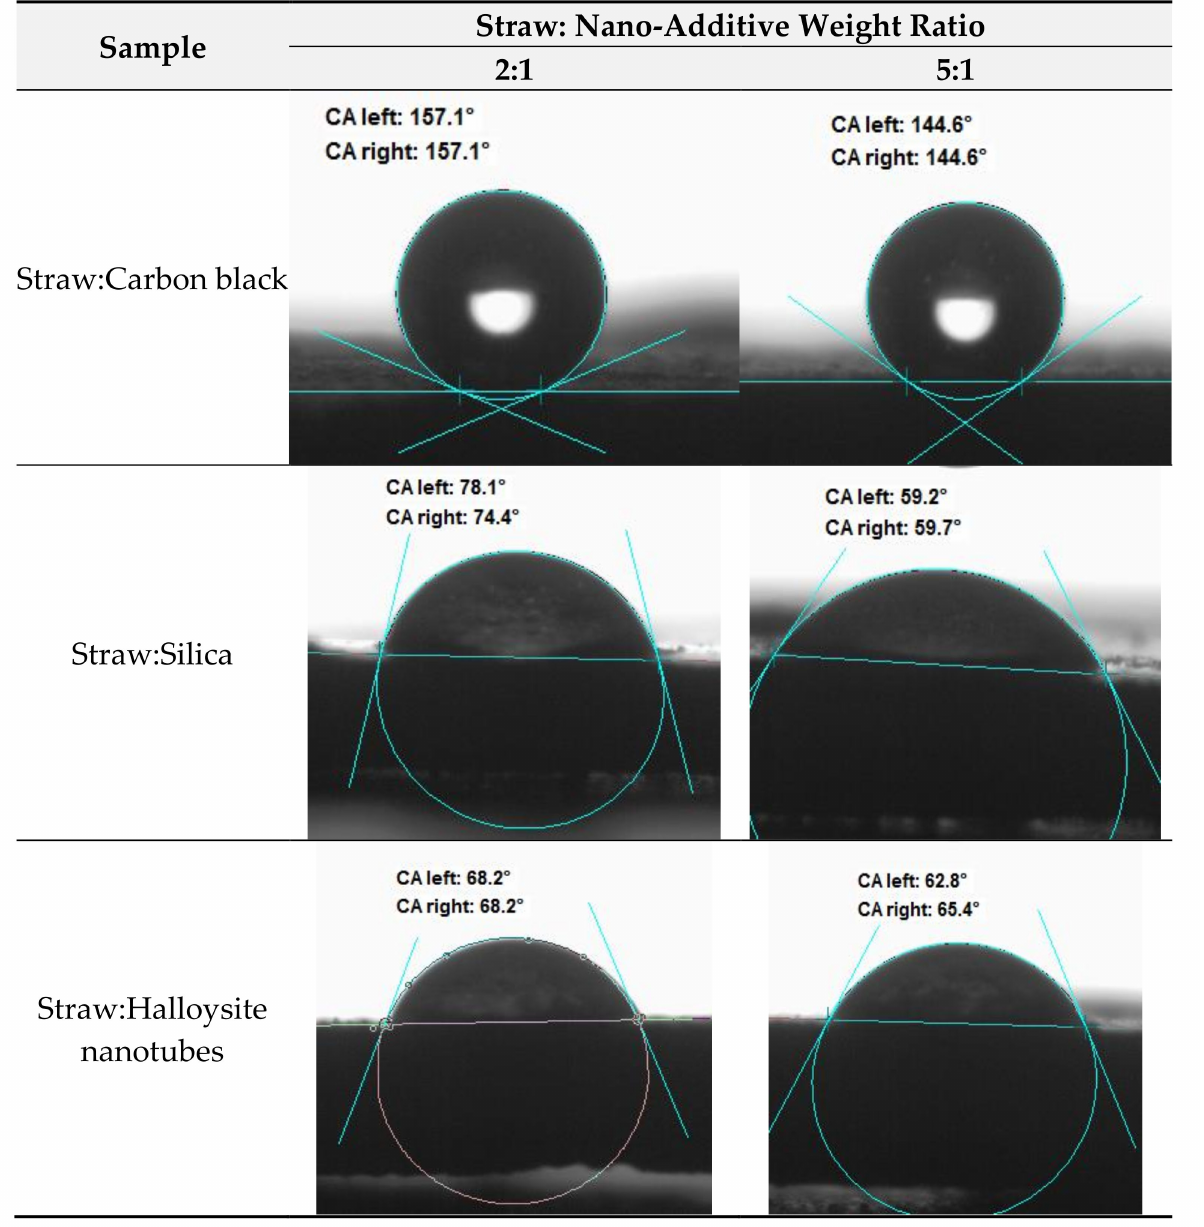
Figure 3. The contact angle (CA) measurements of hybrid